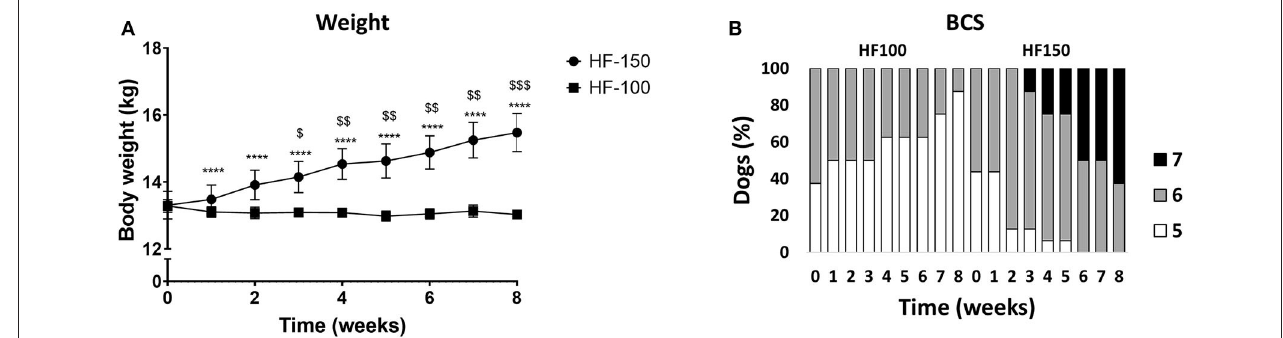
FIGURE 2 | (A) Body weight and (B) Body condition score (BCS) in dogs fed the high-fat diet at maintenance (HF-100; n = 8) and at 150% maintenance (HF-150; n = 16) during 8 weeks. Data are mean ± SEM. **** P < 0.0001 for the HF-150 diet vs. week 0, $ P < 0.05, $ P < 0.01, $$$ P < 0.001 HF-150 vs. HF-100 at the same